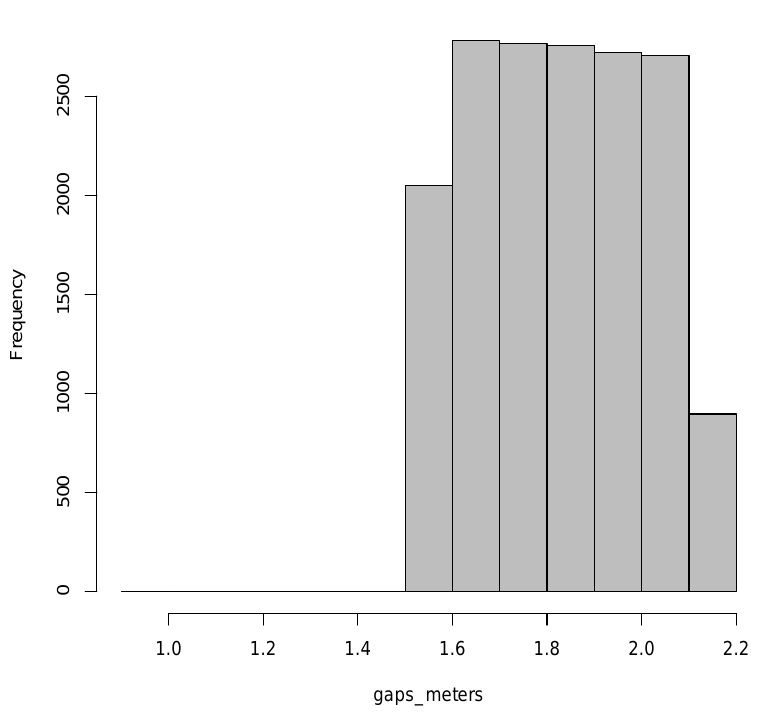
Figure 4. Histogram showing the distribution of gap sizes in the simulated “NOT GAPPY” row population (maximum gap size = 2.1